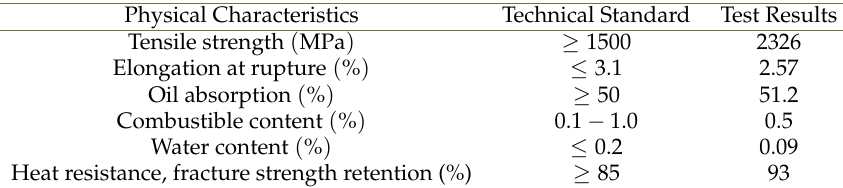
Table 2. Performance indexes and corresponding test results of basalt fiber